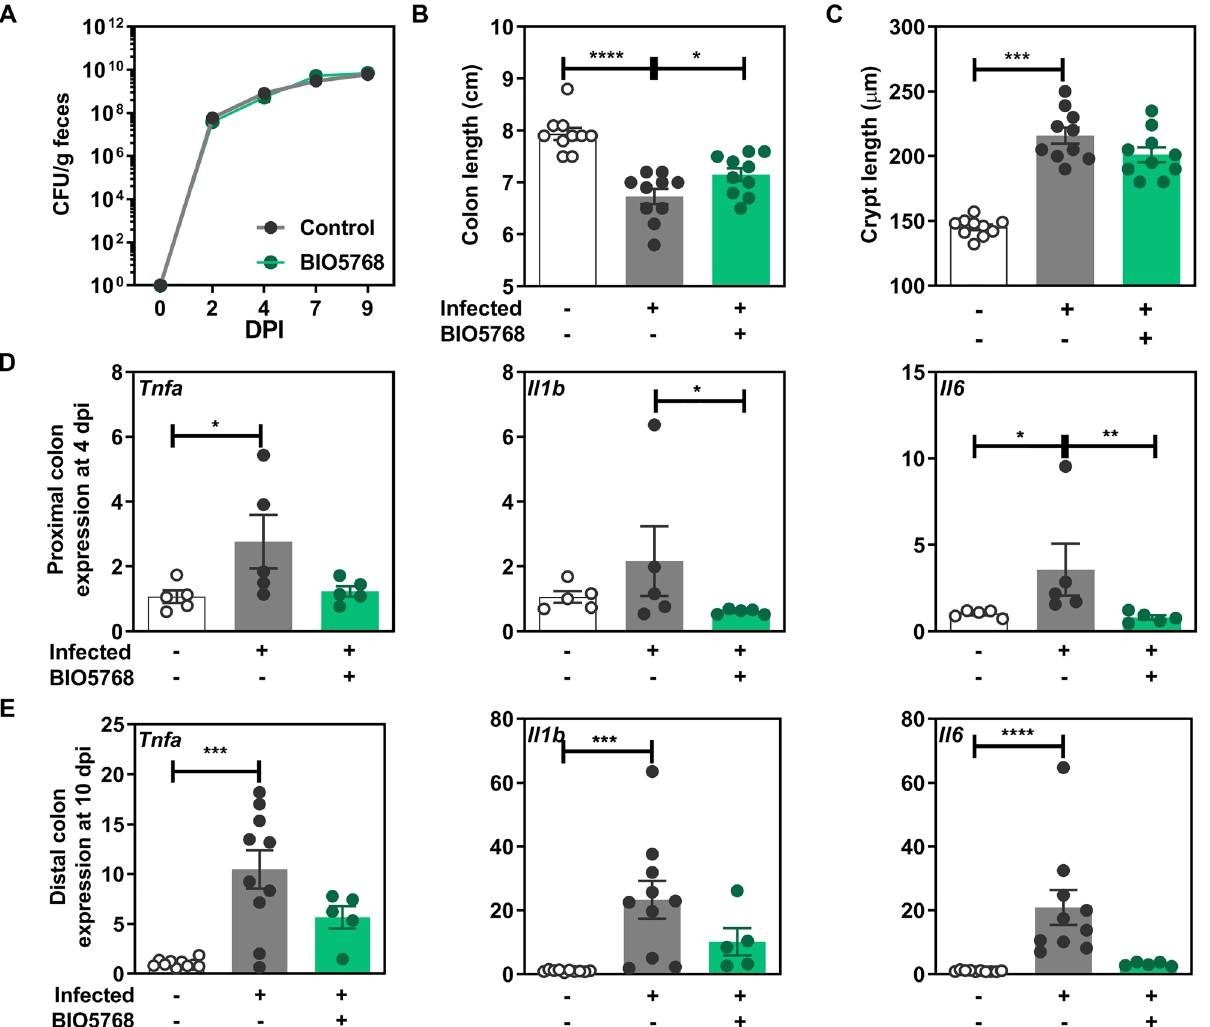
Figure 3. Impact of L. acidophilus BIO5768 supplementation in a mouse model of C. rodentium infection. BIO5768 (5 × 10 8 CFU) was daily administered to C57BL/6J mice 5 days prior to infection and after the infection until the day of sacrifice. Mice were orally inoculated with 1 × 10 9 CFU C. rodentium DBS 120 K strain and sacrificed at either 4 or 9 days after infection. ( A ) Effect of BIO5768 on bacterial load of C. rodentium determined by plating over the course of the experiment, fecal samples dilution on Luria Bertani medium containing 50 µg/ml kanamycin and compared with control infected mice. ( B ) Effect of BIO5768 supplementation on the colon length. ( C ) Effect of BIO5768 supplementation on the crypt length. ( D ) qRT-PCR analysis of the expression of pro-inflammatory genes in the proximal colon of mice after 4 days post infection. ( E ) qRT-PCR analysis of the expression of pro-inflammatory genes in the distal colon of mice after 10 days post infection. Results are expressed as relative gene expressions (2 −∆∆ct ) values, by comparing the PCR cycle thresholds (Ct) for the gene of interest and for the house keeping gene β-actin ( bact ), compared with control mice. Results of a representative experiment out of 2 are expressed as means ± SEM of uninfected control mice (n = 10) and infected mice that are supplemented (n = 5) or not (n = 10) with BI05768. * p < 0.05; ** p < 0.01; *** p < 0.001; **** p <